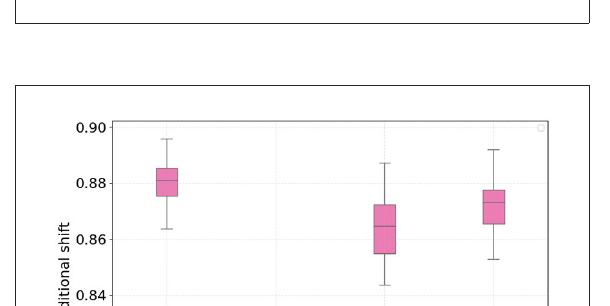
FIGURE1 Boxplots with 30 independent estimates of the aggregate cross-subject conditional shift across different normalization strategies for participants which performed physical activity using a treadmill . Lower values represent smaller estimated conditional shifts.